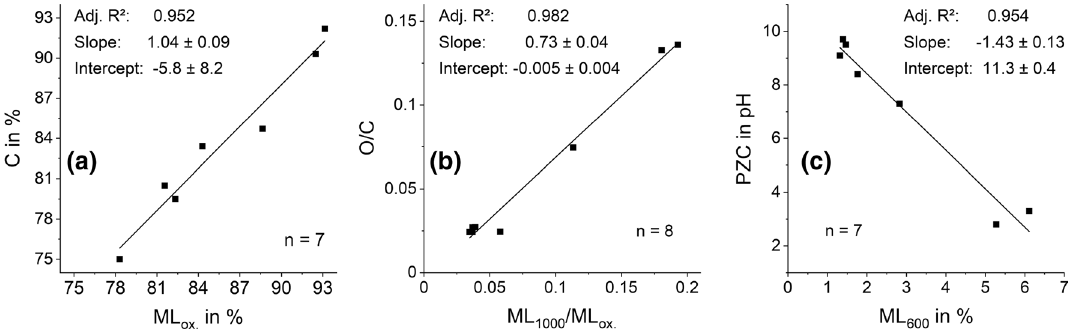
Fig. 5 Linear correlations of a : the oxidative mass loss and the carbon mass content determined by CHNS analysis, b : the O/C ratio and the respective ratio of the surrogates, and c : the pyrolytic mass loss up to 600 Fig. 6 Mass loss profiles (DTG curves) of Coco1, Bitu1, Bitu2, and Hard1 in multiple determinations. DTG curves for Wood1, Wood2, Mix1, and Lig1 are provided in SI (Fig.